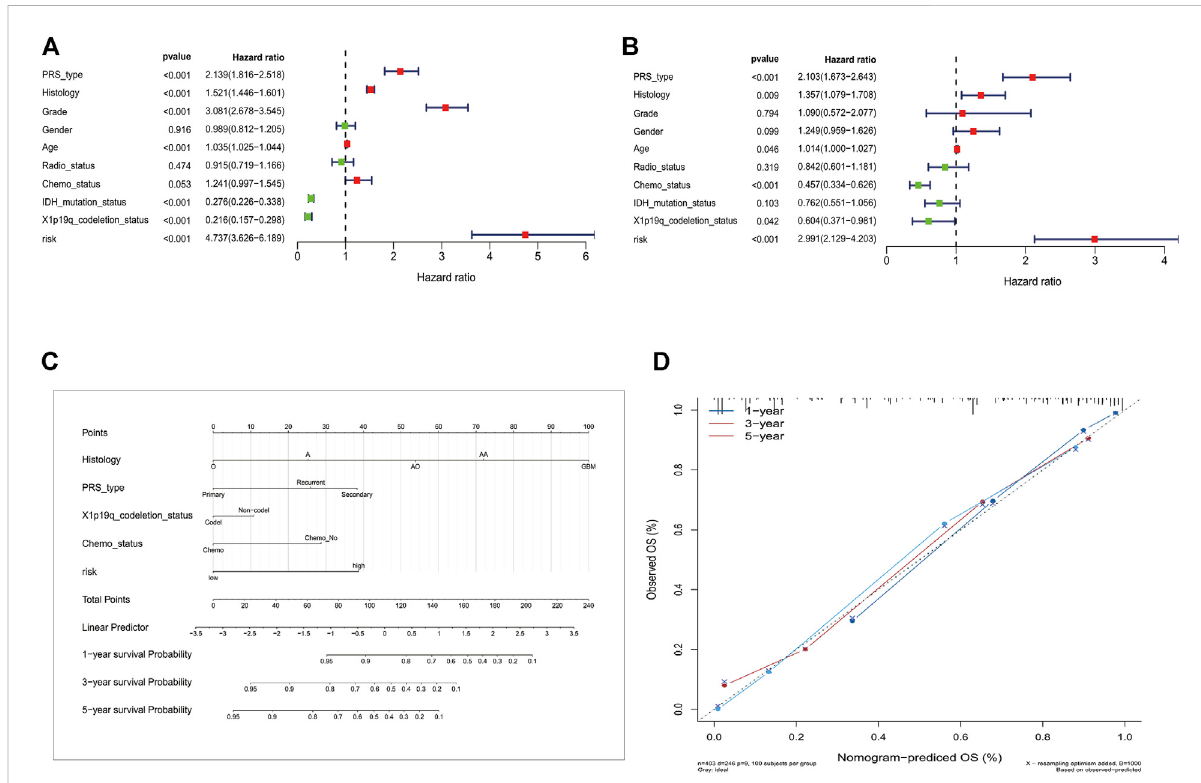
FIGURE 4 Construction of the nomogram model. (A) Univariate and multivariate Cox analyses indicating that the DPS is signi fi cantly associated with OS. (B) Multivariate Cox analyses indicating that the DPS is signi fi cantly associated with OS. (C) Nomogram model for predicting the probability of 1-, 3-, and 5- year OS in Gliomas patients. (D) Calibration plots of the nomogram for predicting the probability of OS at 1, 3, and 5